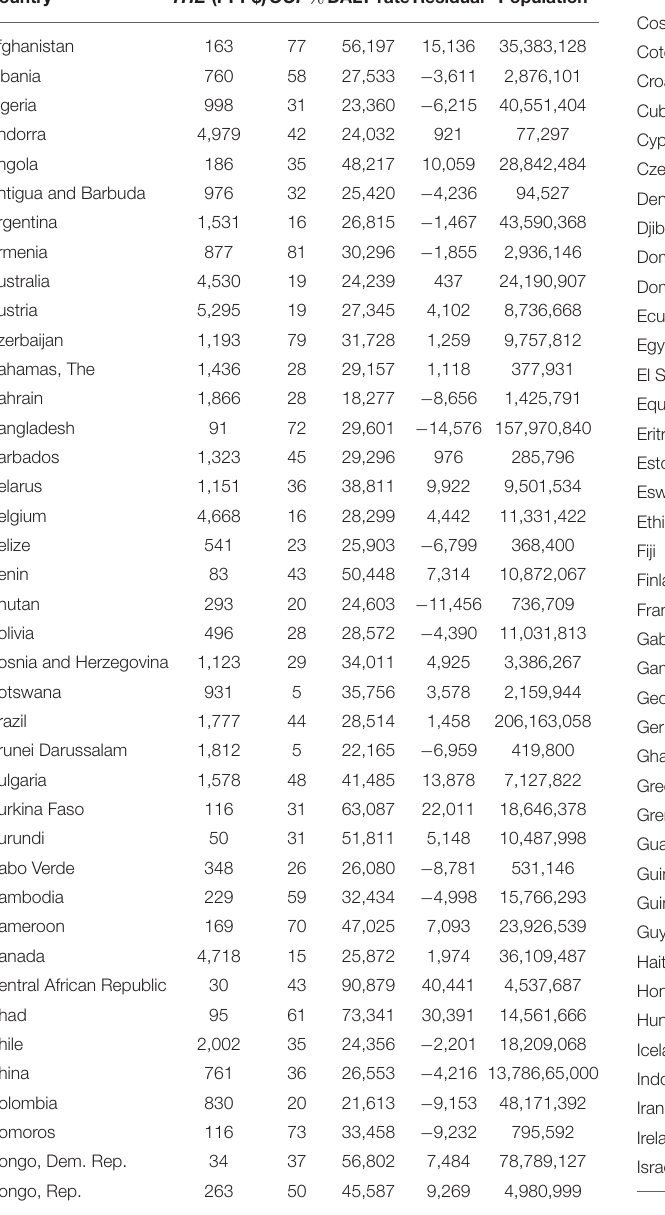
TABLE 11 | Estimated residuals for each country (Afghanistan to Republic of the Congo). Country THE (PPP$) OOP % DALY rateResidual Population Afghanistan